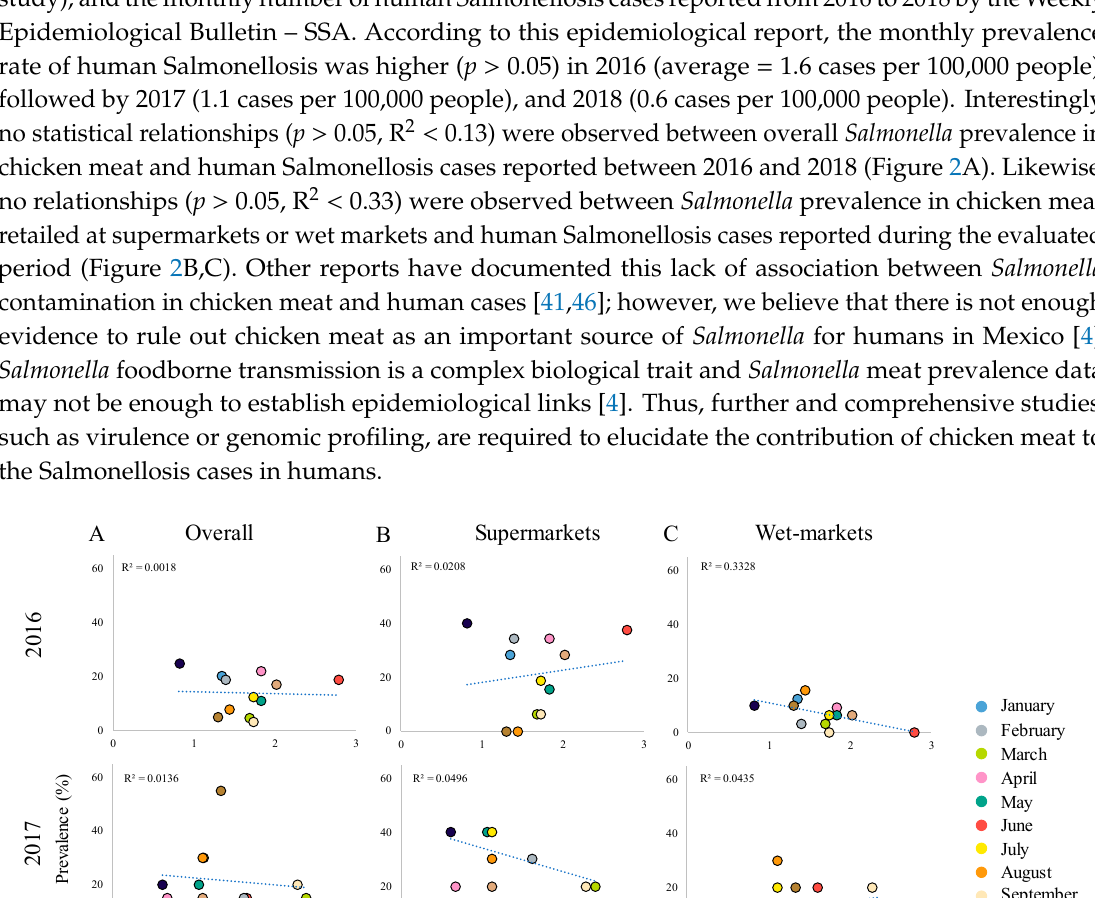
Figure S1: Influence by market type (A), over time (B) and season e ff ect (C) on Salmonella prevalence in